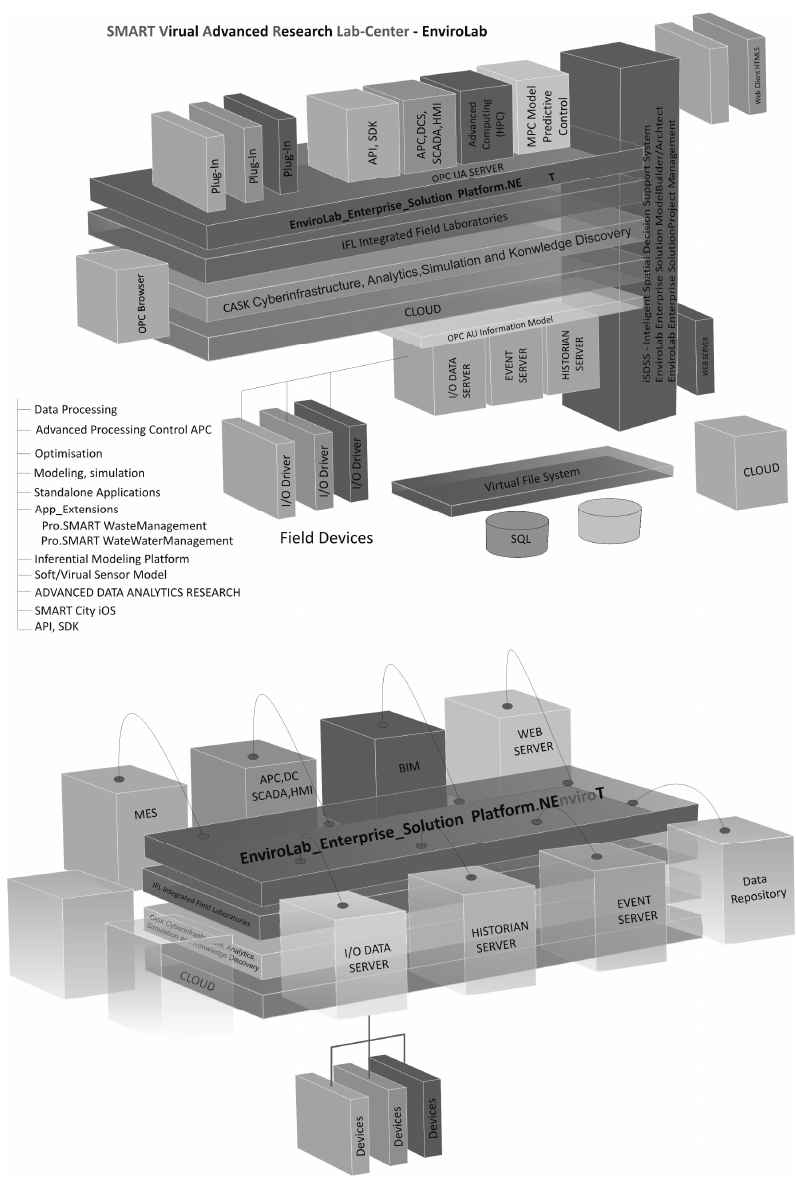
Figure 2. Specialized platform of the virtual laboratory EnviroLab [own elaboration] [12].